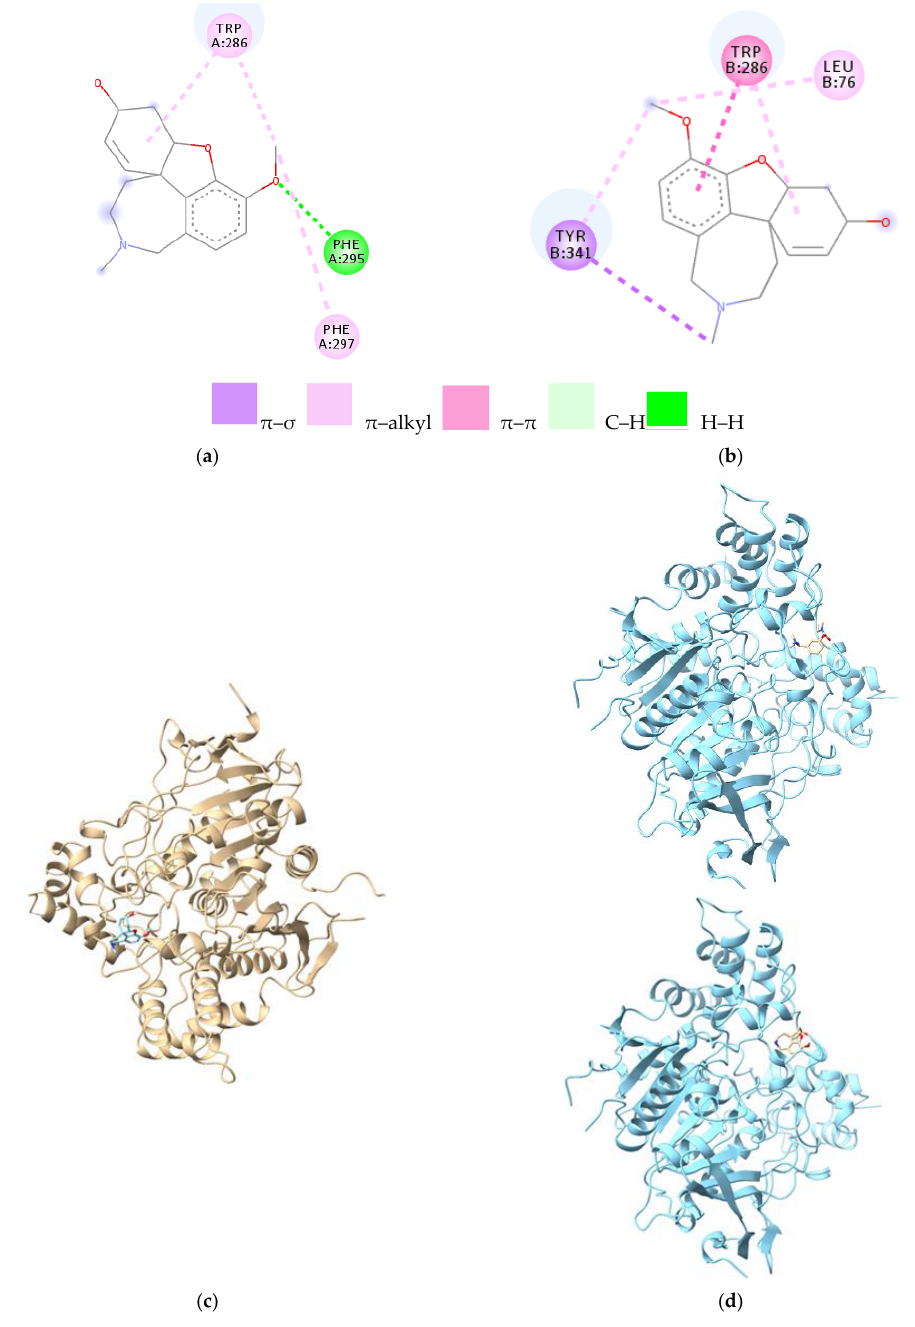
Figure 4. 2D and 3D representation of the ligand–protein complex; ( a ) galantamine–AChE (chain A) complex; ( b ) galantamine–AChE (chain B) complex; ( c ) 3D structure of the galantamine–AChE (chain A) complex; ( d ) 3D structure of the galantamine–AChE (chain B) complex. Legend: TYR—tyrosine; TRP—tryptophan; PHE—phenylalanine; LEU—leucine. The letters A and B represent the chain, and the number represents the numbering of the amino